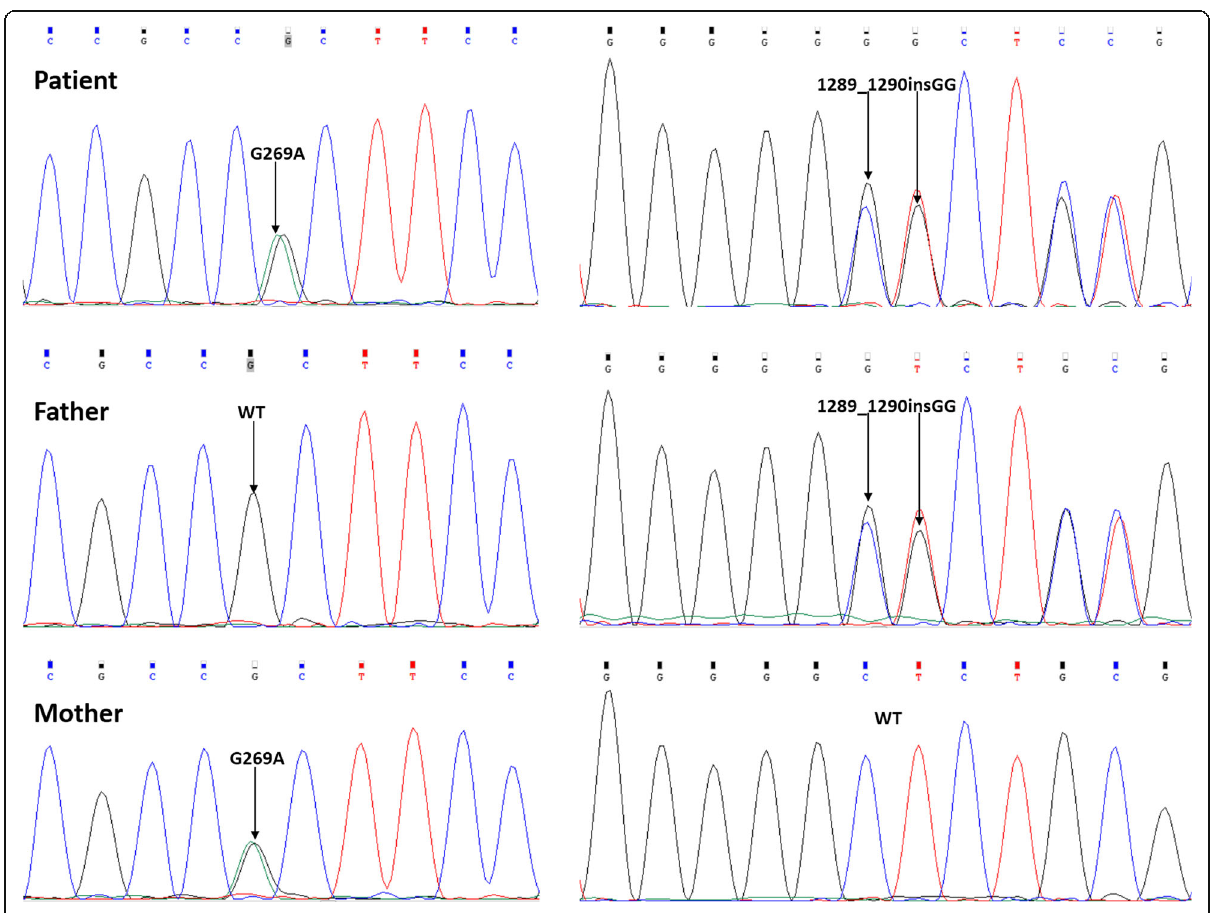
Fig. 1 Sanger sequencing for the two mutations in this family. The patient carried two heterogeneous mutations: c.G269A/WT and c.1289_1290insGG/ WT. The father carried one heterozygous mutation of c.1289_1290insGG/WT, while the mother carried another heterozygous mutation of